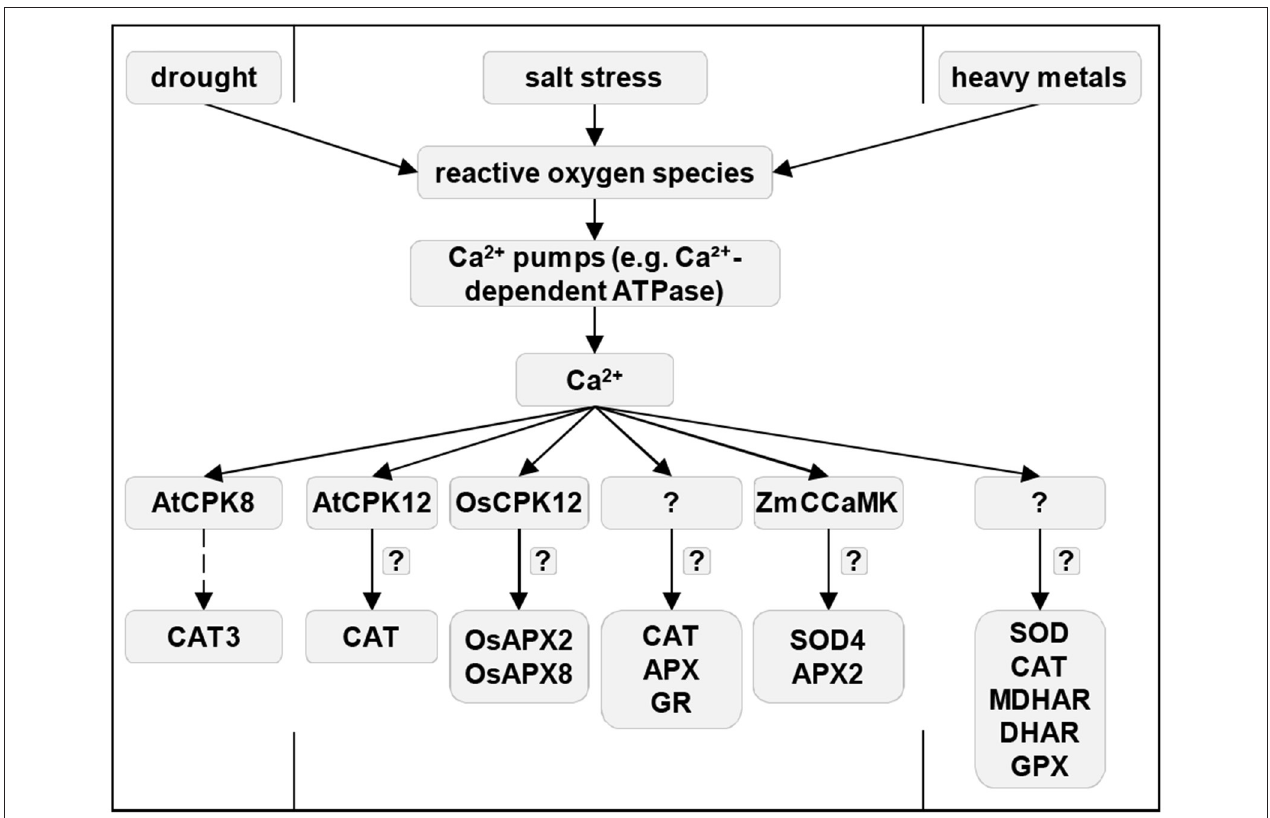
FIGURE 3 | Mechanisms of Ca 2 + -mediated regulation of antioxidant enzymes during stress in plants. Solid arrows indicate induction, and dashed arrows show phosphorylation. Question mark means an unknown regulation. APX, ascorbate peroxidases; CAT, catalase; CPK, Ca 2 + -dependent protein kinases; DHAR, dehydroascorbate reductase; GPX, glutathione peroxidase; GR, glutathione reductase; MDHAR, monodehydroascorbate reductase; SOD, superoxide dismutase; ZmCCaM, Ca 2 + /calmodulin-dependent protein kinase from Zea mays